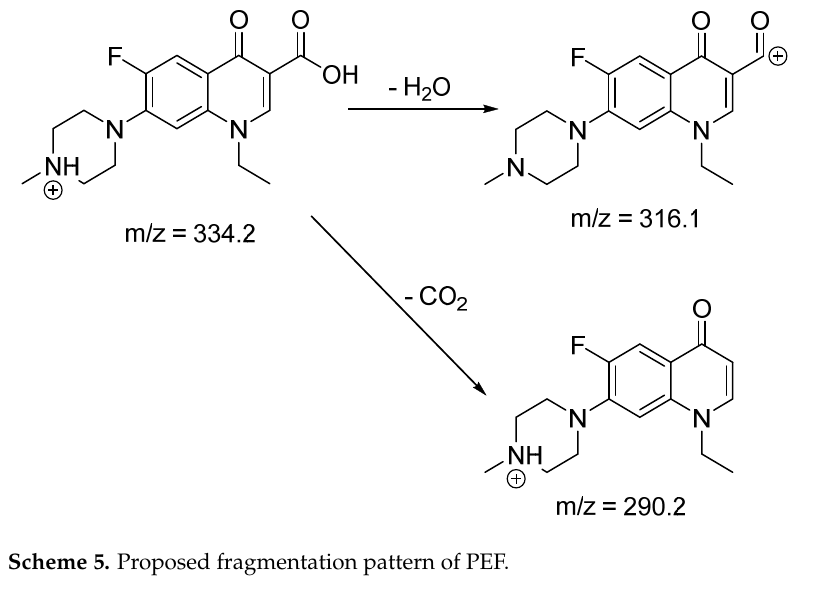
Table 5. Proposed structures of the degradation products of PEF.